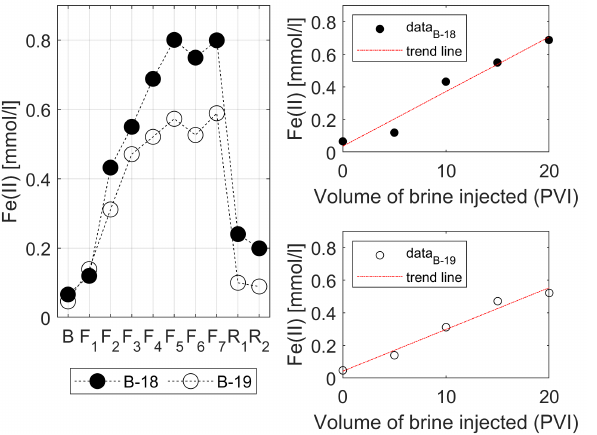
Figure 8. Fe(II) concentration in Berea core plugs flooded with 2D*TB EDTA and trend